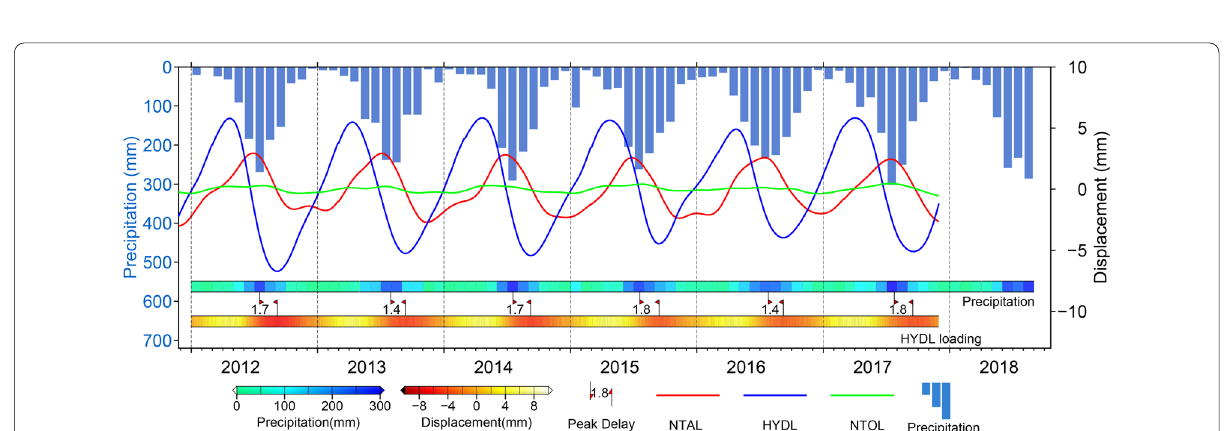
Fig. 3 Loading components in Southwest China. Stack-average deformation of 41 stations yielded by hydrological loading (HYDL), non-tidal atmospheric loading (NTAL), and non-tidal ocean loading (NTOL) represented by the blue, red, and green lines, respectively [inferred from the surface loading model